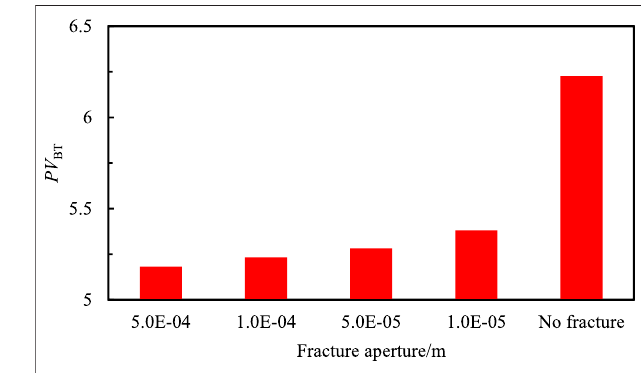
FIGURE8| Effectofthefractureapertureonthebreakthroughvolumeof injected